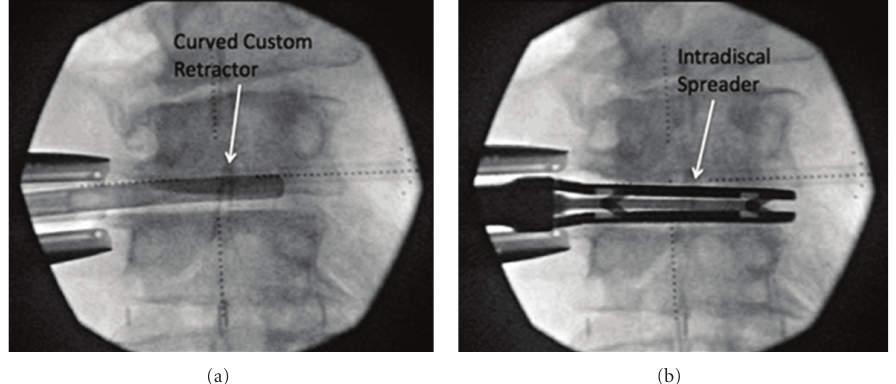
Figure 1: Intraoperative anterior-posterior radiographs demonstrating the curved retractor anterior to the disc space during dissection of the sympathetic plexus o ff the great vessels (a), and the intradiscal spreader in the disc space used to break the contralateral ALL remnant rather than blindly incising (b).